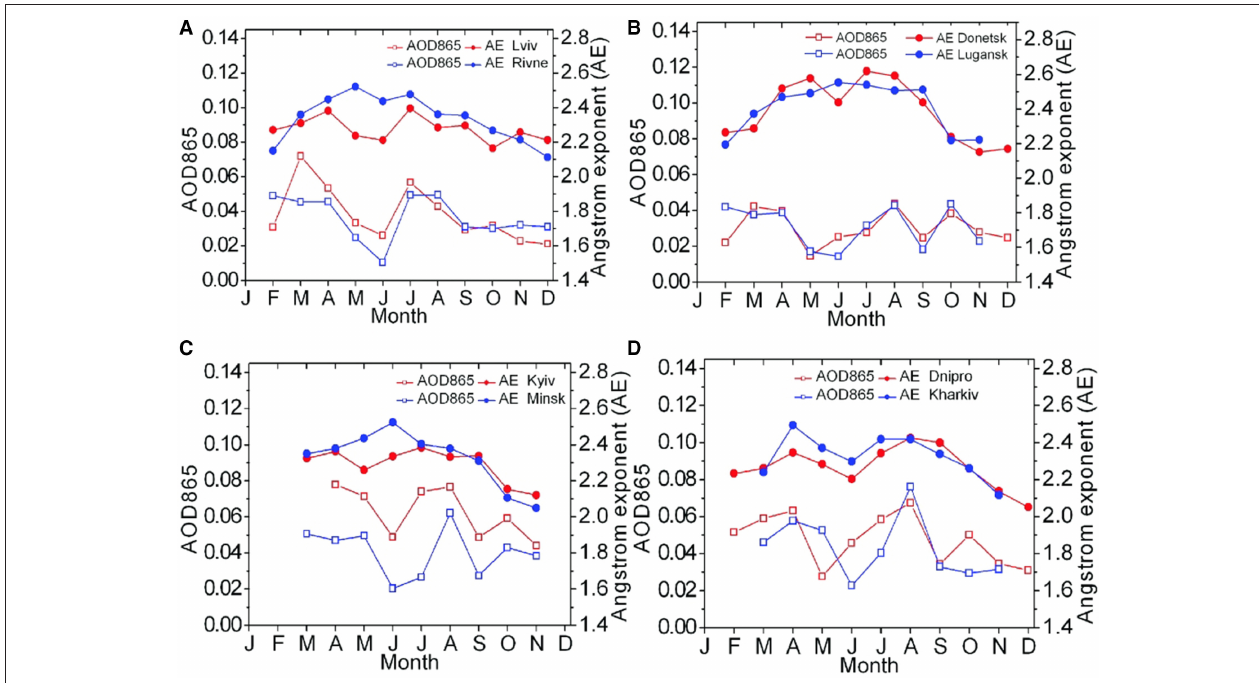
FIGURE 11 | AOD (865nm) and Ångström exponent AE (670–865nm) seasonal variations. The values are averaged over 2008–2011 for cities: Kyiv, Minsk, Donetsk, Lugansk, Dnipro, Kharkiv, Lviv, and Rivne areas on the base of POLDER data. The figure is modified after ( Milinevsky et al.,